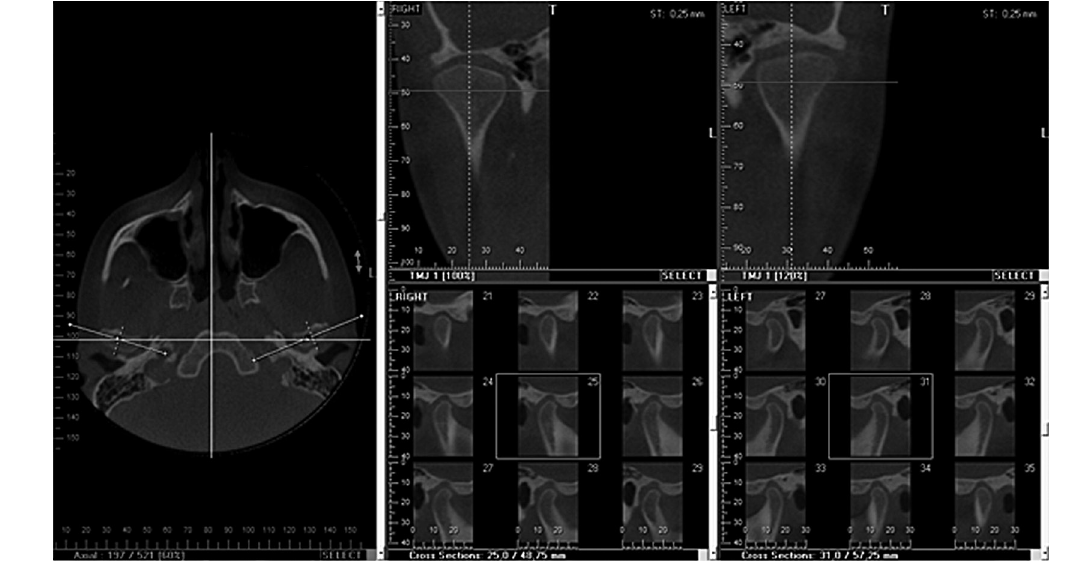
Figure 2. Cone-beam computed tomography images for TMJ diagnosis taking into consideration the right and left sides, respectively.